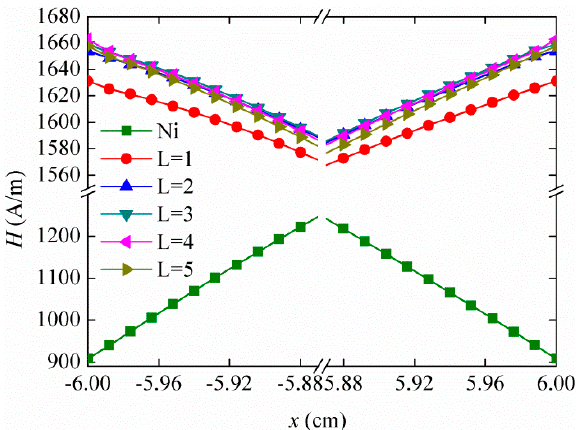
Figure 5. The amplitude of the magnetic field along x ‐ direction for the single Ni plate and Ni in FeCuNbSiB/Ni ( L = 1–5).